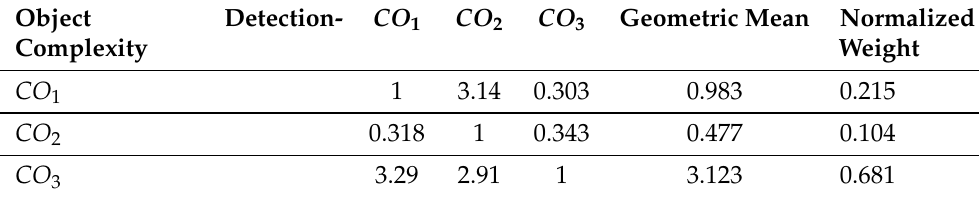
Table 11. Comparison between suitable components for object detection with respect to complexity.